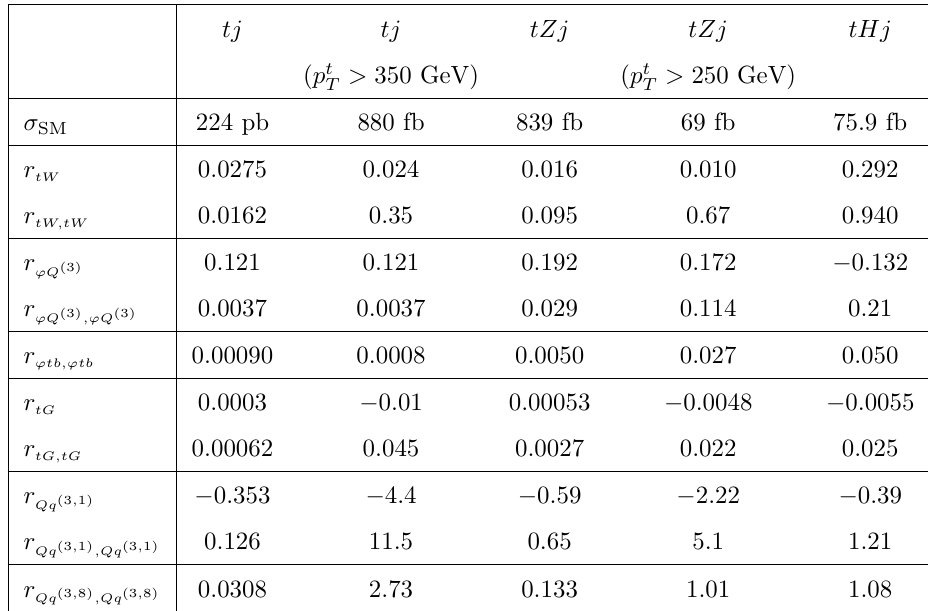
Table 6 . Comparison among the NLO sensitivities of tj (inclusive and with p t (inclusive and with p t > 250 GeV), and tHj to the six operators which are common to the three T processes, i.e., those entering in tj . The interference term r square r = (cid:27) are given for each operator. (cid:27) i;i i;i =(cid:27) SM